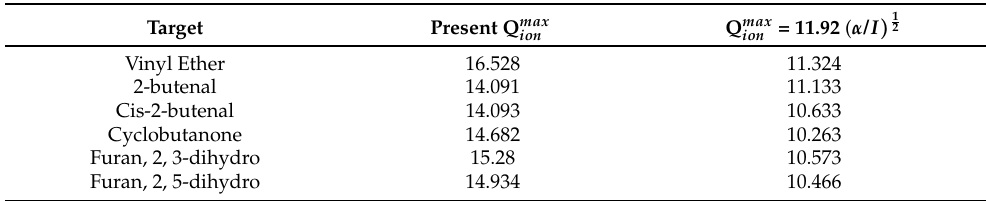
Table 3. Comparison of present maximum ionization cross section value with the relation given in Harland et al.